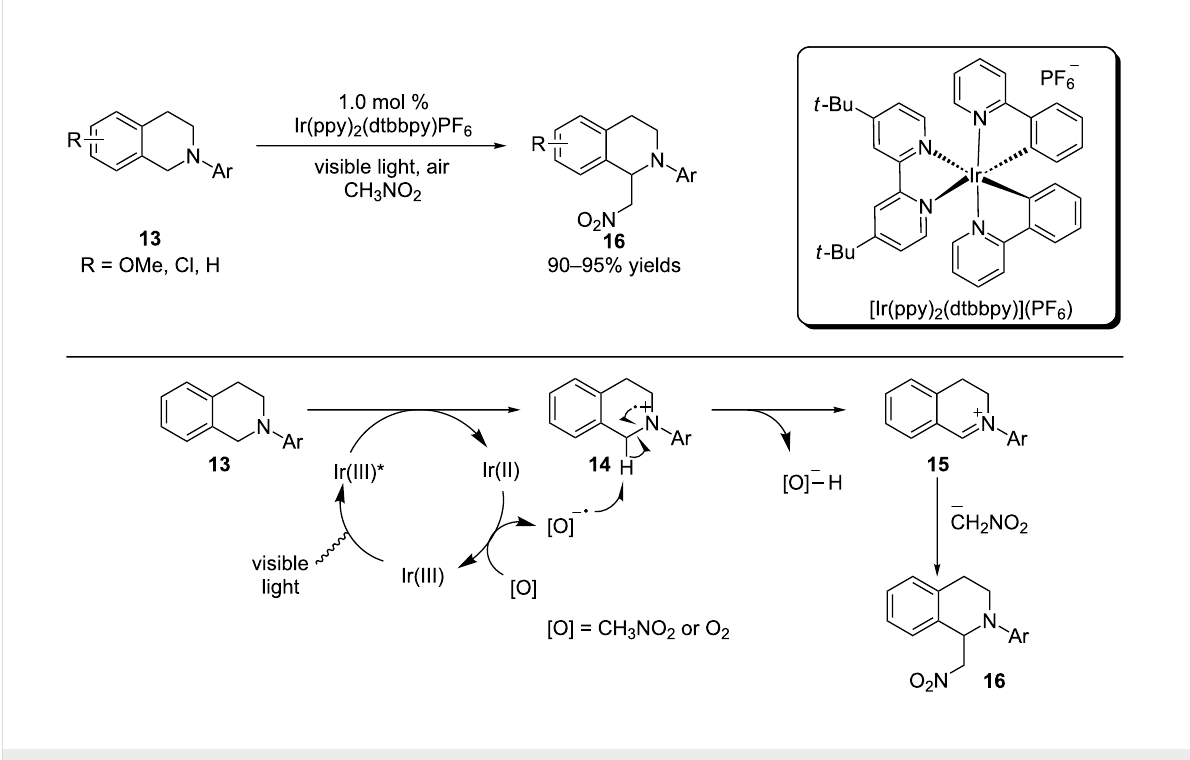
Scheme 3: Photoredox aza-Henry